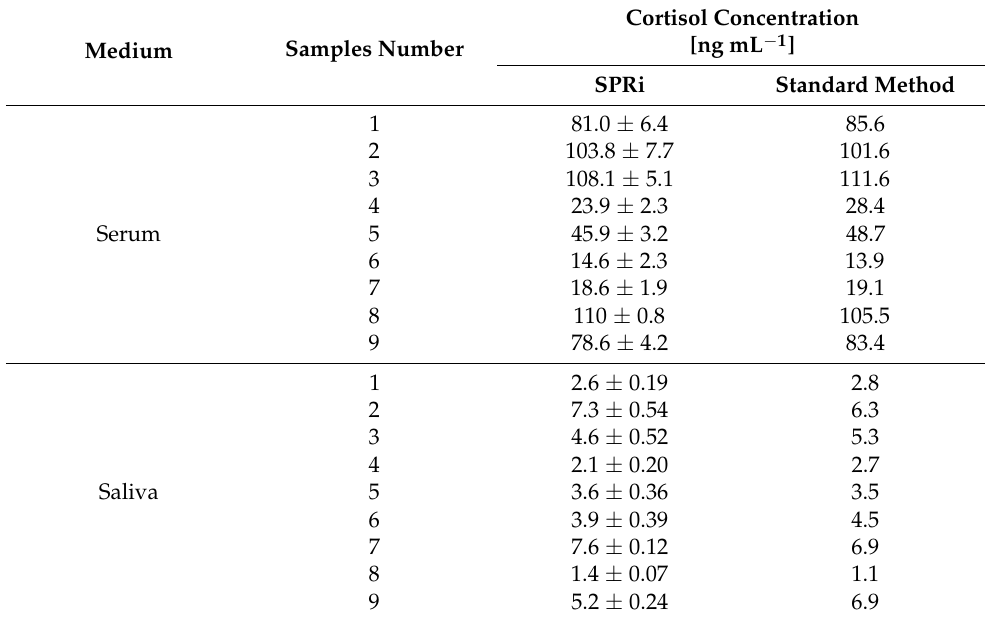
Table 3. Comparison of cortisol concentration in human blood serum and saliva measured by the SPRi method and a standard